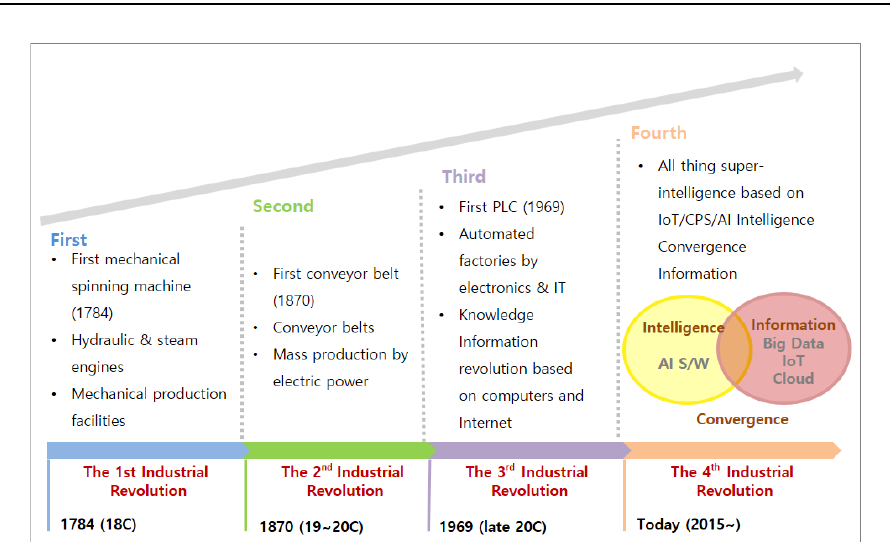
Figure 1. Phased changes of industrial revolutions.